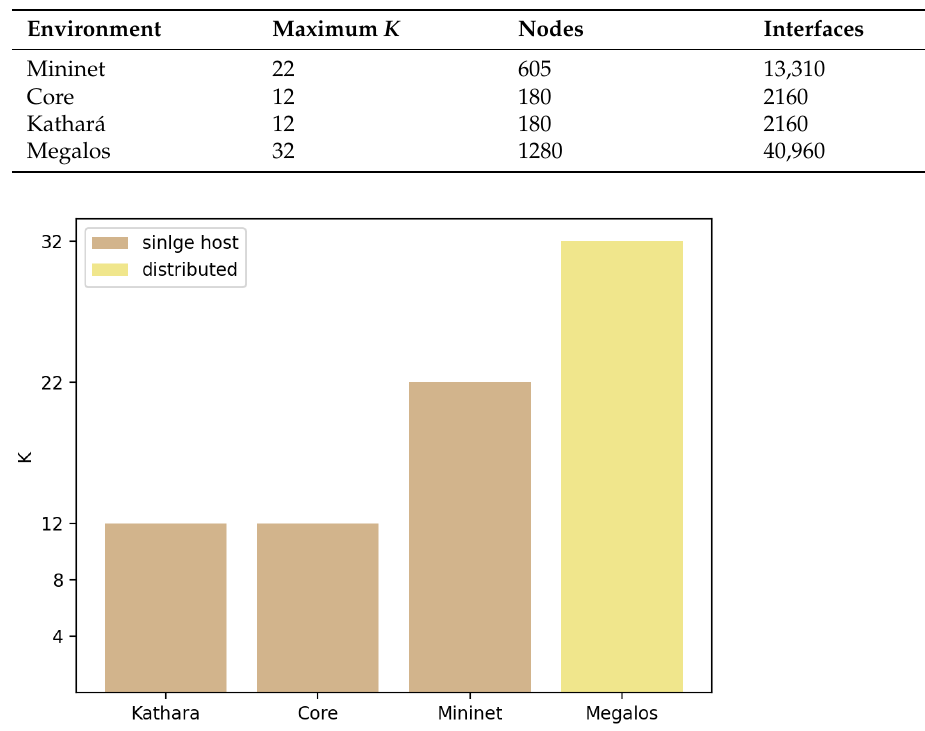
Table 2. Scale results using BGP.